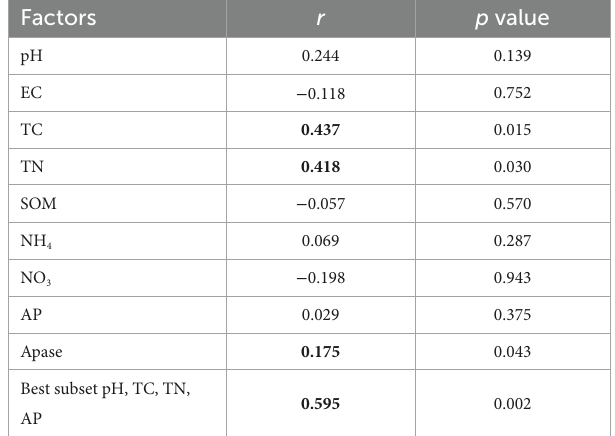
TABLE 2 Pearson’s correlation coefficients between soil properties and bacterial community. Factors